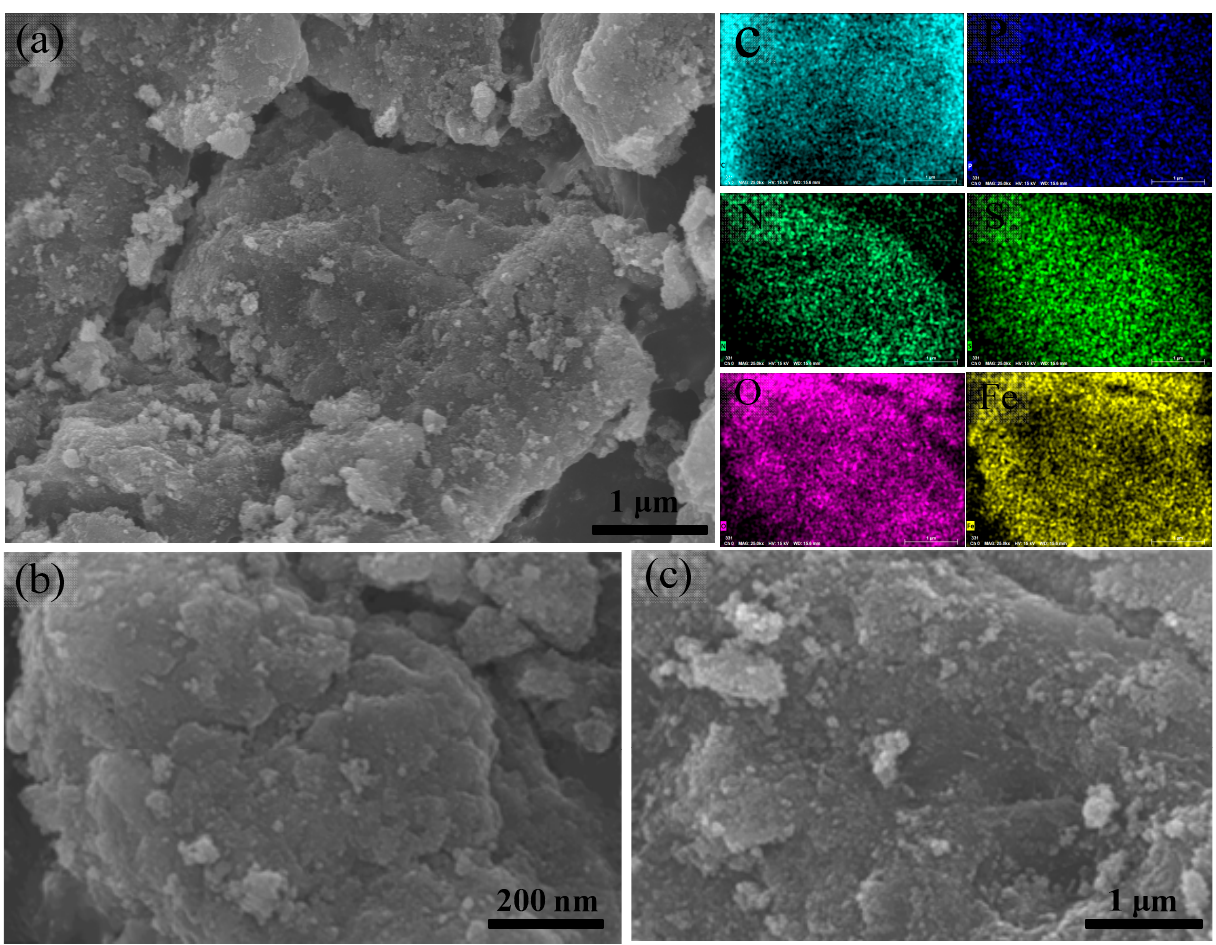
Figure 3. SEM and element distribution images of 10%-Fe 3 O 4 @SC adsorbent. ( a , b ) The micro morphology of fresh adsorbent at different magnifications. ( c ) The micro morphology of adsorbent after adsorption.